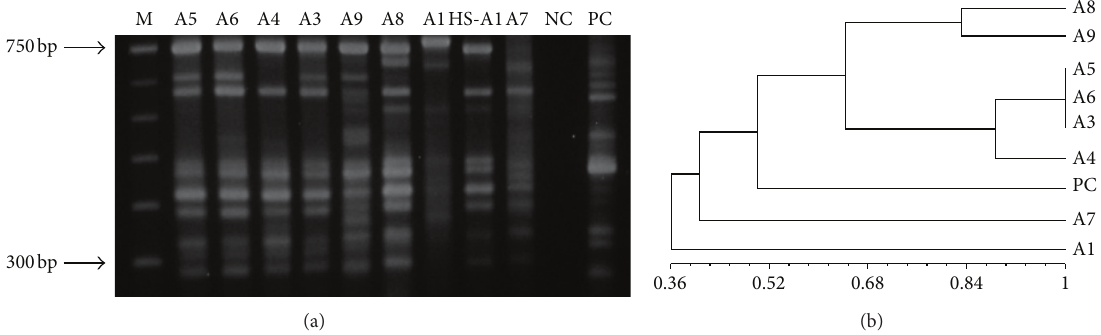
Figure 1: (a) Agarose gel electrophoresis showing representative genetic profiles generated by LSSP-PCR from parasites of cutaneous lesions of 8 animals (A8, A9, A5, A6, A3, A4, A7, and A1); HS-A1: health skin from animal A1. (b) Phenetic analysis using the Jaccard coefficient of similarity and UPGMA algorithm. M: 100bp DNA marker; NC: negative control; PC: positive control ( L . (V . ) braziliensis reference strain MHOM/BR/1975/M2903).